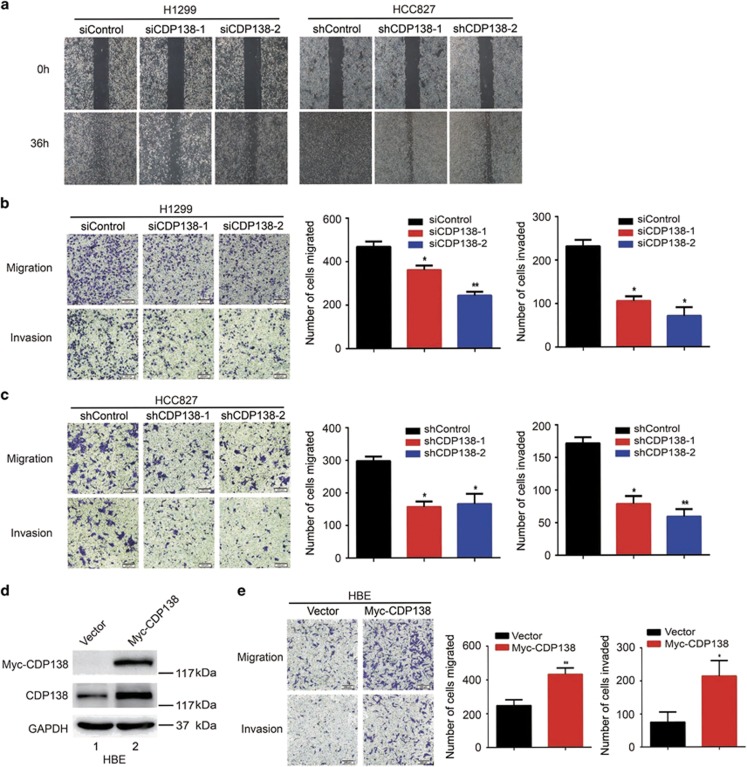
Knocking down CDP138 inhibits the migration and invasion of lung cancer cells. (a) Cell migration is decreased in CDP138 knockdown cells as determined using wound healing assay. (b,c) Left panel: Transwell assays showing that CDP138-depleted H1299 cells (b) or HCC827 cells (c) have lower migratory and invasive capacity than those of control cells. Right panel: Quantification of migration and invasion in H1299 cells (b) or HCC827 cells (c). *P<0.05 and **P<0.01 compared with controls cells. (d) HBE cells were transfected with the indicated plasmids. After 24 h, cells were harvested and analyzed via Western blotting with indicated antibodies. (e) Left panel: cell migration and invasion is measured using transwell assays. Right panel: quantification of migration and invasion in HBE cells. *P<0.05 and **P<0.01 compared with control cells